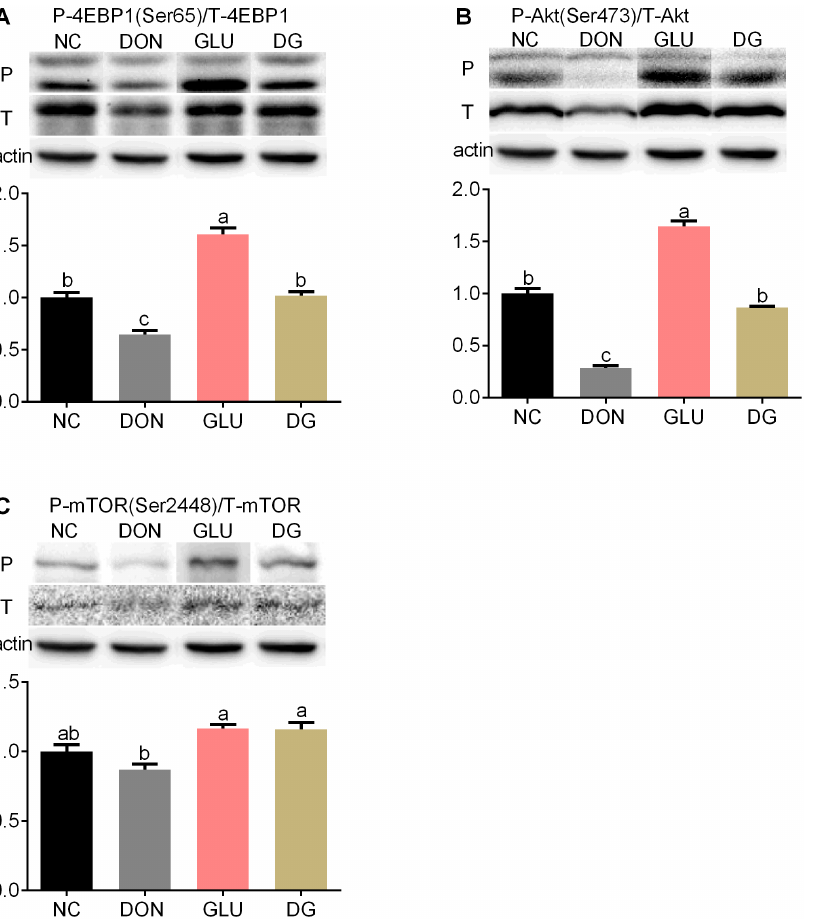
Figure 8. Activation of mTOR in jejunum. (Up) Representative western blots of total 4EBP1(T-4EBP1), phosphorylated 4EBP1 (Ser65) (P-4EBP1), total Akt (T-Akt), phosphorylated Akt (Ser473) (P-Akt), total mTOR (T- mTOR), phosphorylated mTOR (Ser2448) (P- mTOR) in jejunum of piglets fed the various dietary treatments. b -actin was the loading control. (Down) Quantification by image analysis of 4EBP1, Akt and mTOR phosphorylation. Dietary treatments were NC, an uncontaminated basal diet, DON, the basal contaminated with 4 mg/kg deoxynivalenol, GLU, uncontaminated basal diet with 2% (g/g) glutamic acid supplementation, and DG, deoxynivalenol-contaminated (4 mg/kg) basal diet with 2% (g/g) glutamic acid supplementation. n=7 for